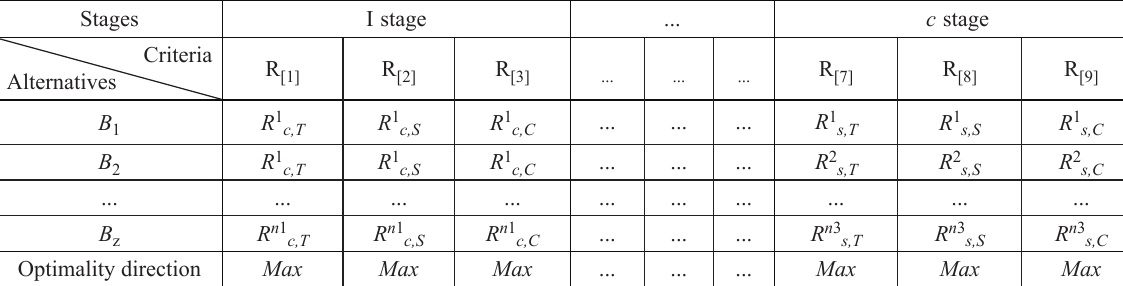
table 2. Decision table for alternative combinations of modernization measures